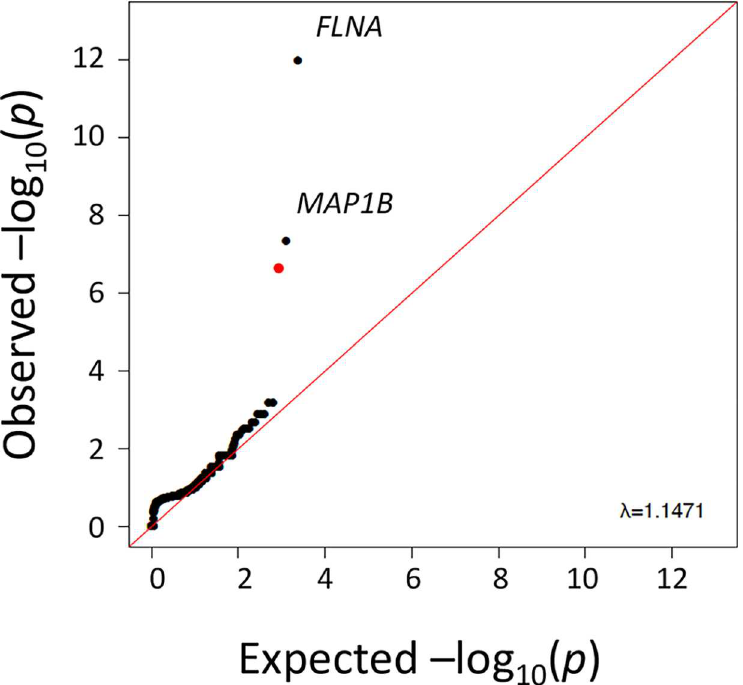
Fig 1. Quantile-quantile plot for gene-level association tests interrogating LoF variants. Black dots represent transformed p values against the expected transformed p values for genes with qualifying LoF variants. The red dot corresponds to the p value associated with SON however all four variants driving this signal were found to be false positives with Sanger sequencing. The red line indicates the expectation under the null model of no effect on risk.